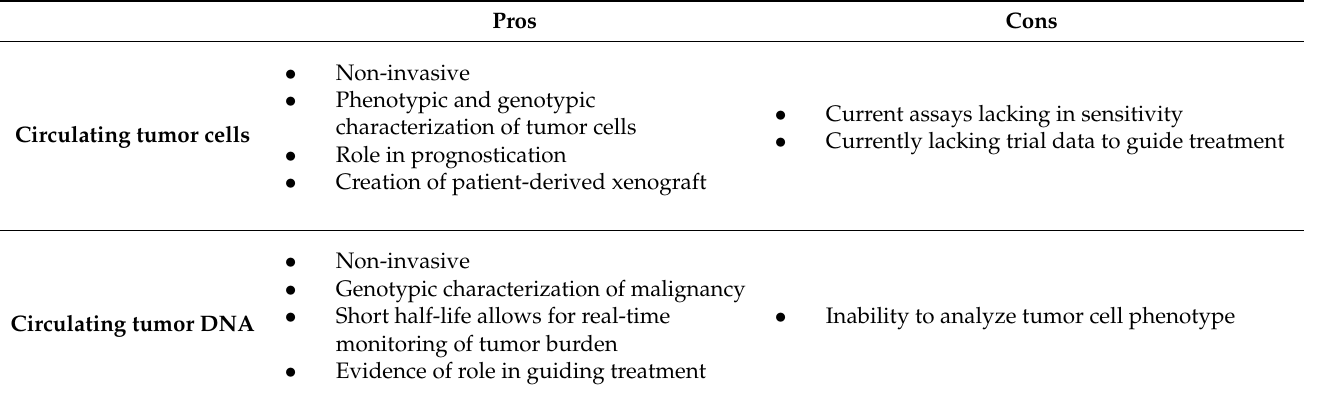
Table 3. The comparison (advantages and disadvantages) between CTC and ctDNA. Pros